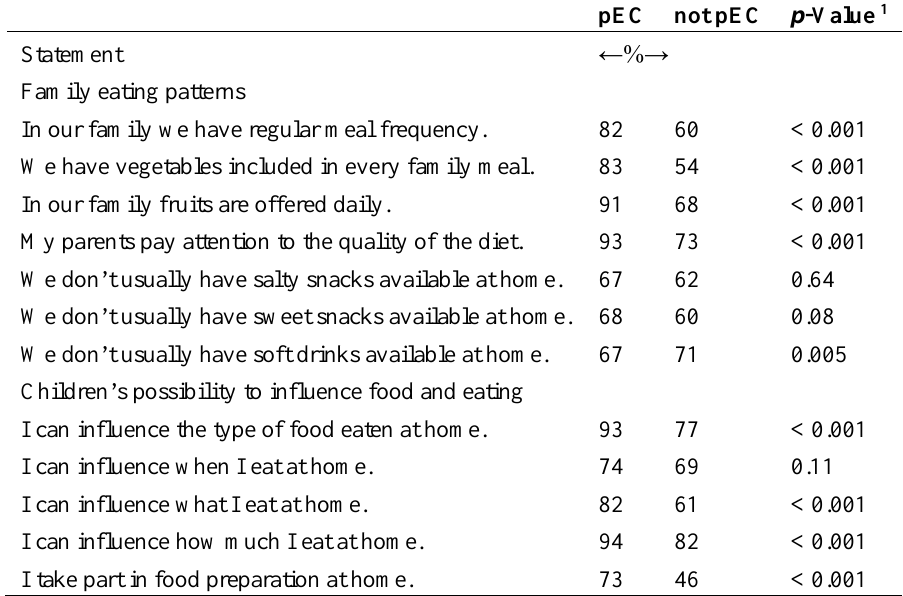
Figure 3. Meal frequency during school days in the presumably eating competent (pEC) and not eating competent (not pEC) groups (percentage of adolescents who consumed meals daily, n = 961–974 out of 976). Frequencies were generated by cross-tabulations using chi-square test for statistical significance (** p < 0.01, *** p < 0.001). Table 3. Family eating patterns and adolescents’ opportunity to influence food and eating at home in the presumably eating competent (pEC) and not eating competent (not pEC) groups ( n = 963–973 out of 976). Percentage (%) of adolescents who “agree” or “somewhat agree” with the